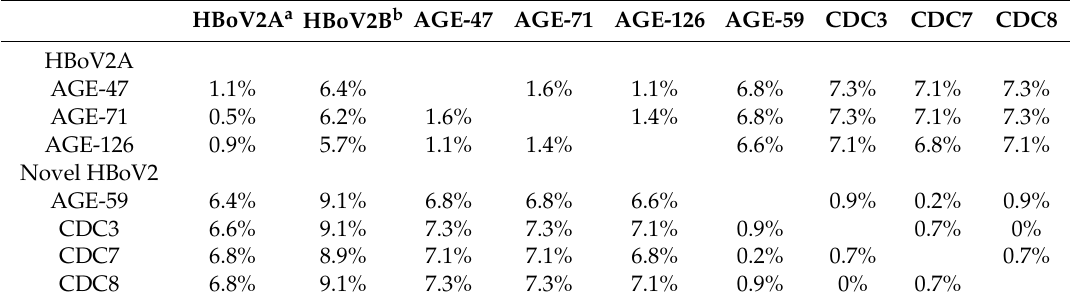
Table 2. Divergence between the Taiwan HBoV2 sequences and genotypes for the VP1 gene